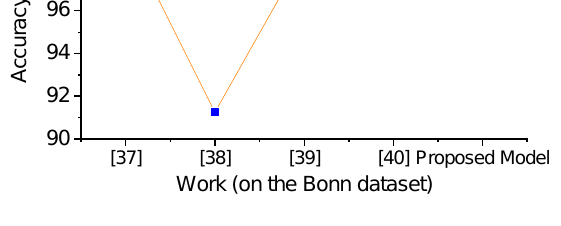
( b ) On the CHB-MIT dataset. Accuracy of the compared algorithms and the proposed model for seizure detection on the Bonn dataset.